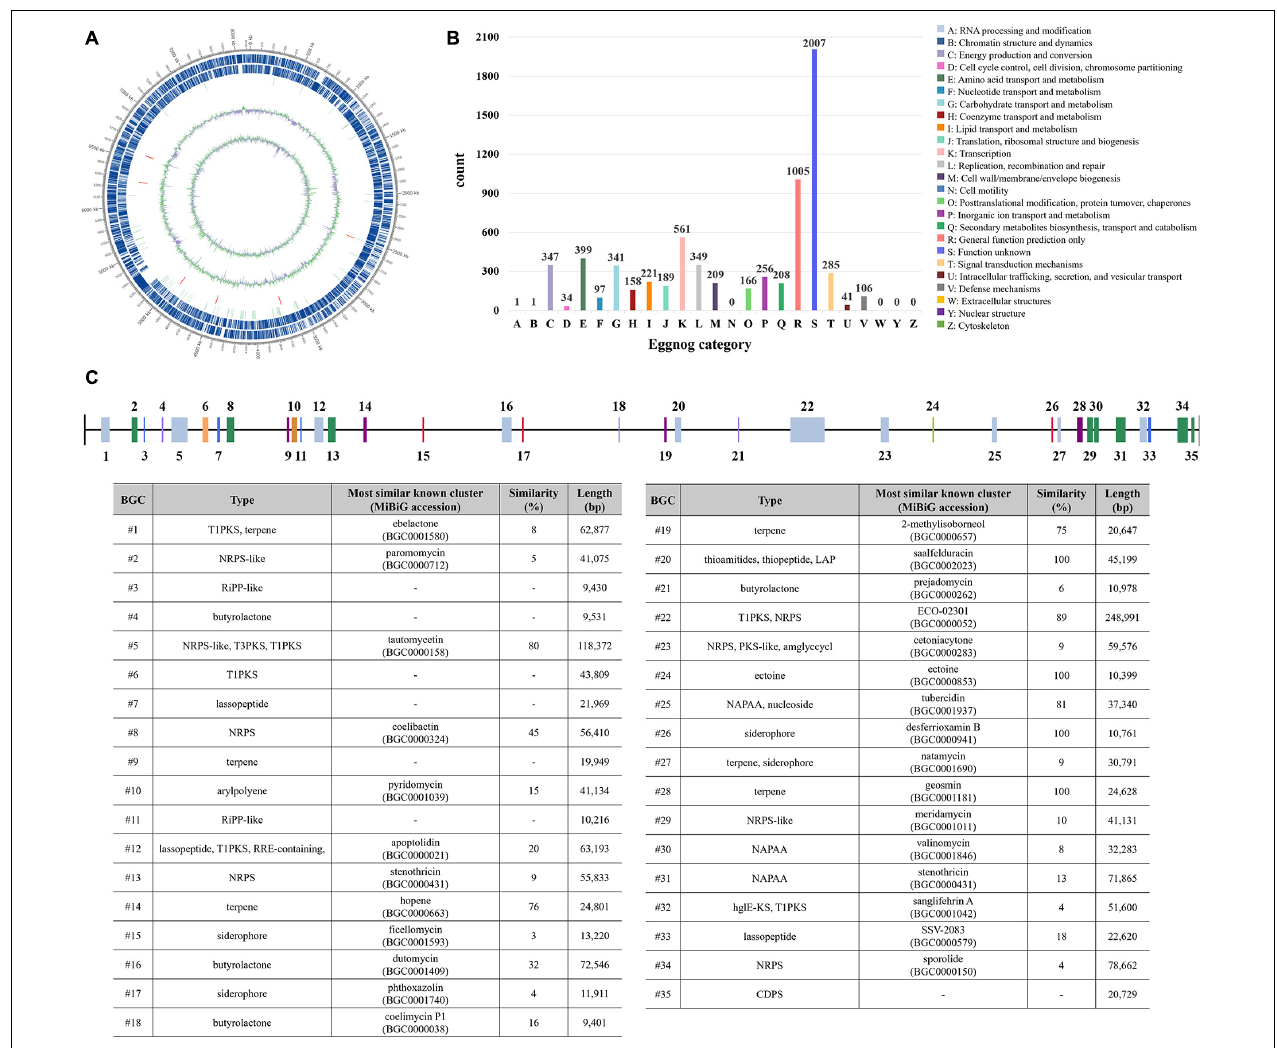
FIGURE 4 | (A) Circular whole-genome map drawn by applying the annotation result of the S. rubrisoli Inha501 chromosome. Marked characteristics are shown from the outside to the center; CDS on the forward strand, CDS on the reverse strand, tRNA, rRNA, GC content, and GC skew (B) Classification of CDS by eggnog annotation (C) Analysis of secondary metabolite biosynthetic gene clusters by antiSMASH 5.0.